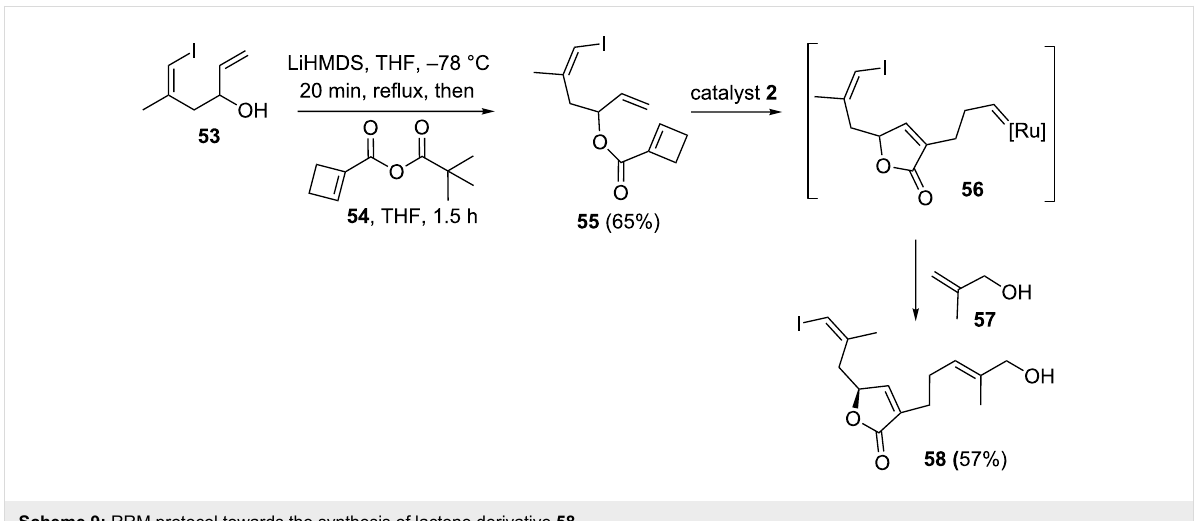
Scheme 9: RRM protocol towards the synthesis of lactone derivative 58